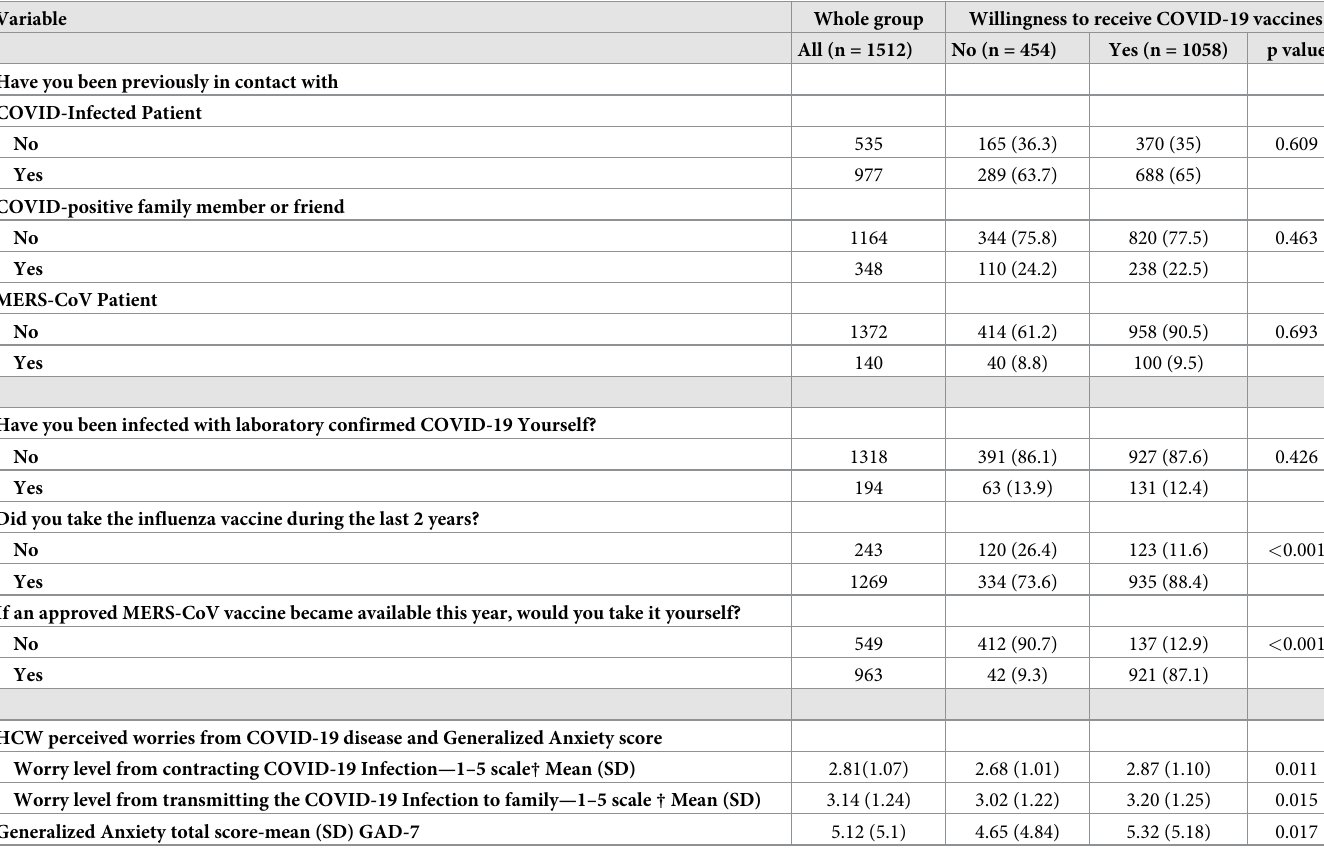
Table 3. Past infection, exposure and worry levels from COVID-19 (N = 1512) and their willingness to receive potential COVID-19 vaccines.